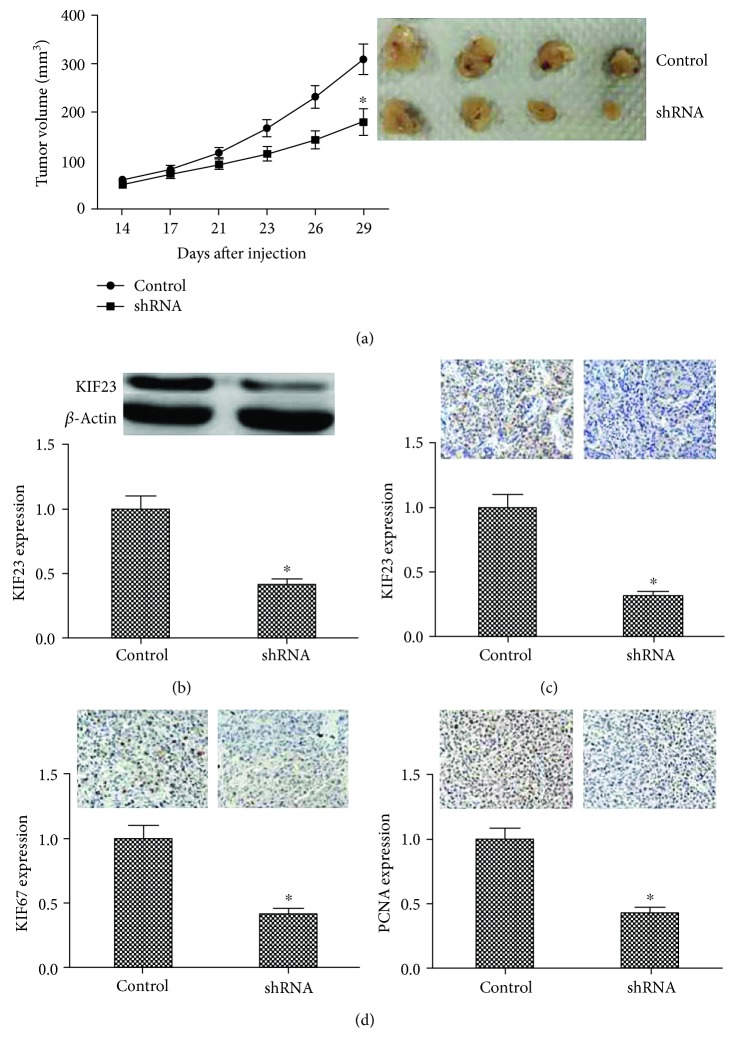
The association between KIF23 and the proliferation of gastric cancer in mice. (a) MGC-803 cells were infected with shKIF23 or shControl lentivirus and subcutaneously implanted into nude mice. After 2 weeks, tumors were isolated and photographs were then taken every other week (n = 4 in each group). Tumor growth curves were calculated according to the average volume of 4 tumors for each group. (b, c) Immunohistochemistry and western blot analysis: the expression level of KIF23 in tissues of the shKIF23 and shControl groups. (d) Immunohistochemistry analysis: the difference in the expression of Ki67 and PCNA between the shKIF23 and shControl groups. Results are presented as mean ± SD (∗P < 0.05).